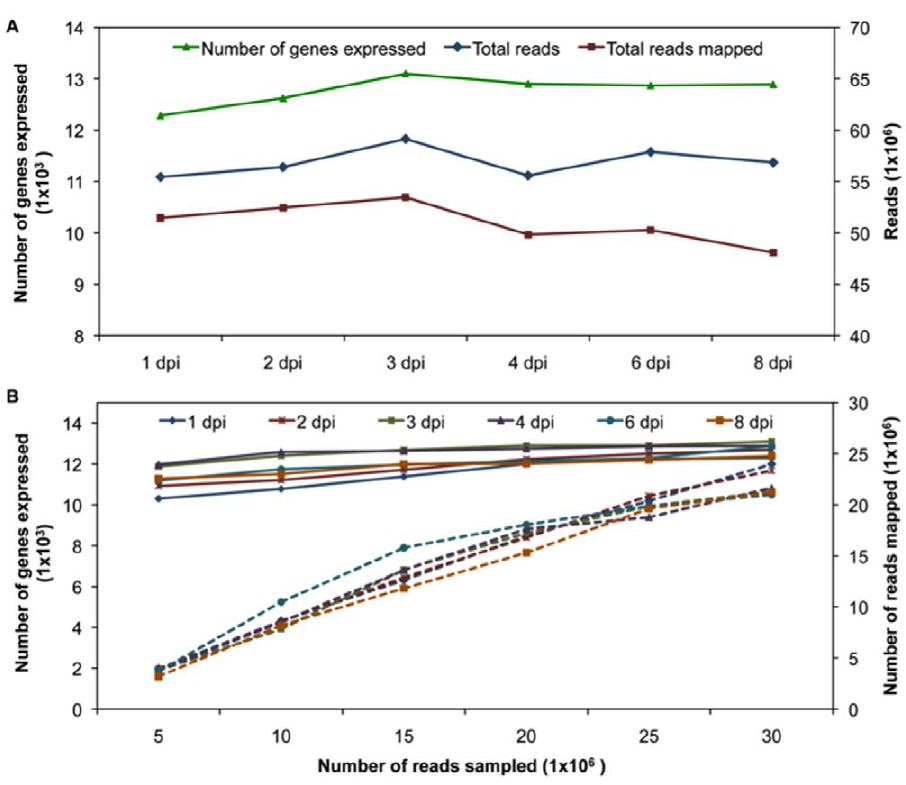
Figure 3. Comparison of total mRNA-Seq reads, reads mapped and number of genes expressed. A . Total number of reads, total reads mapped, and number of genes expressed as determined from pooling of both biological replicates are shown. Reads were mapped to the C. sativus genome [6] using Bowtie version 0.12.5 [57] and TopHat version 1.2.0 [56]. Fragments per kilobase pair of exon model per million fragments mapped (FPKM) values for the annotated C. sativus genes were calculated using Cufflinks version 0.9.3 [58]. Genes were considered expressed if the FPKM value and 95% confidence interval lower boundary FPKM value was greater than 0.001 and zero, respectively. B . Effect of sampling depth on detection of expressed genes. For all time points 5, 10, 15, 20, 25, and 30 million reads were randomly selected from the total pool of reads. Read mapping and expression abundance estimates were performed as described above. Solid lines indicate number of genes expressed and the dashed lines indicate number of reads mapped at different time points. dpi, days post-inoculation.